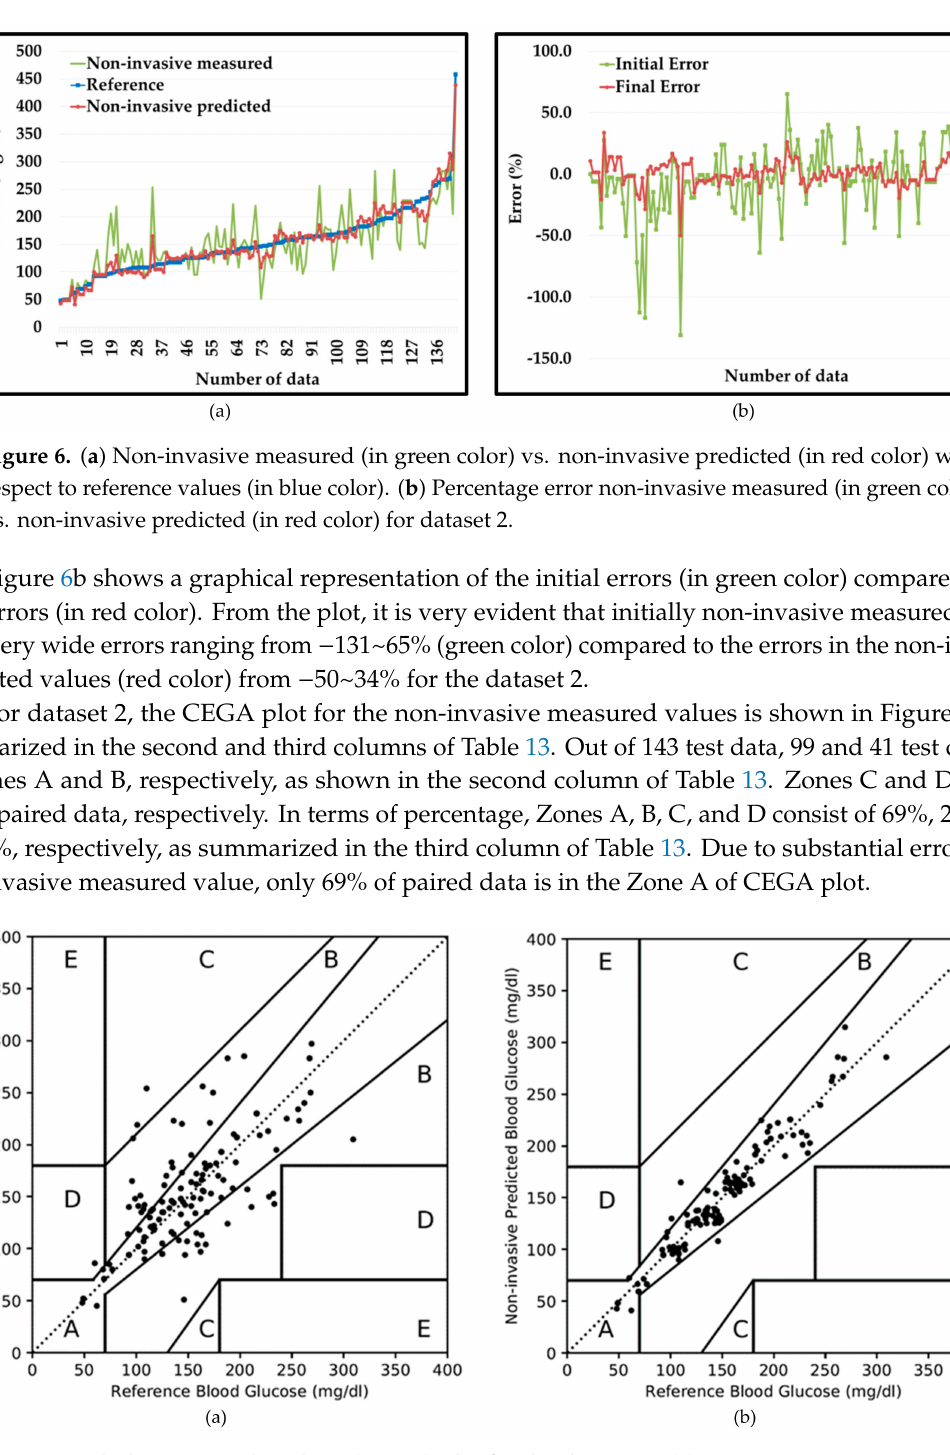
Figure 7. Clarke error grid analysis (CEGA) plot for the dataset 2. ( a ) For non-invasive measured values, ( b ) for non-invasive predicted